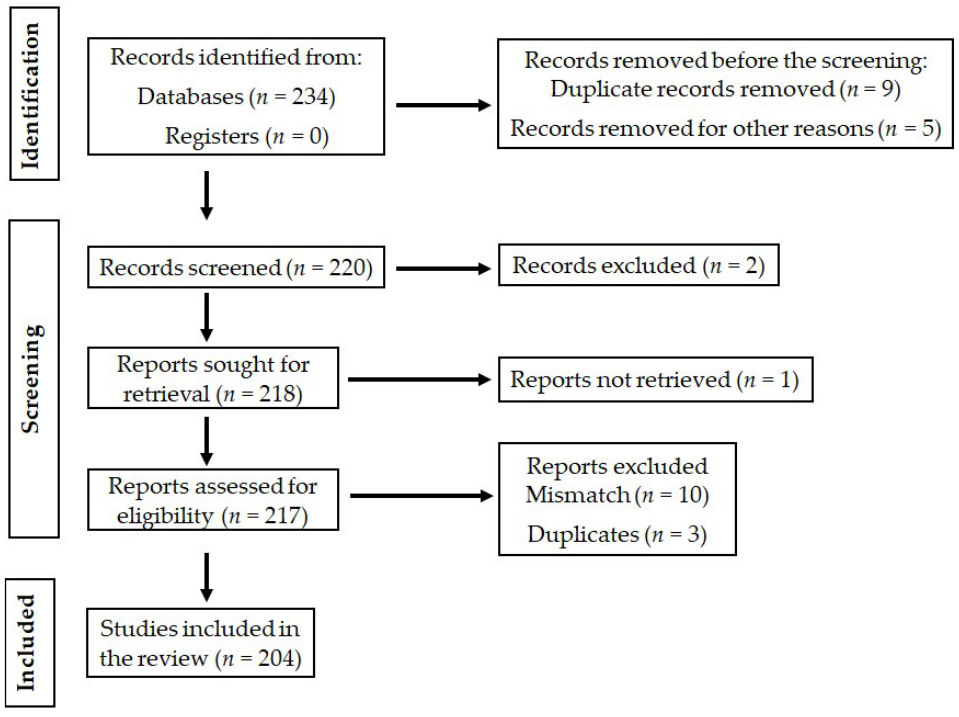
Figure 1. Schematic representation of the PRISMA chart explaining the selection of studies.